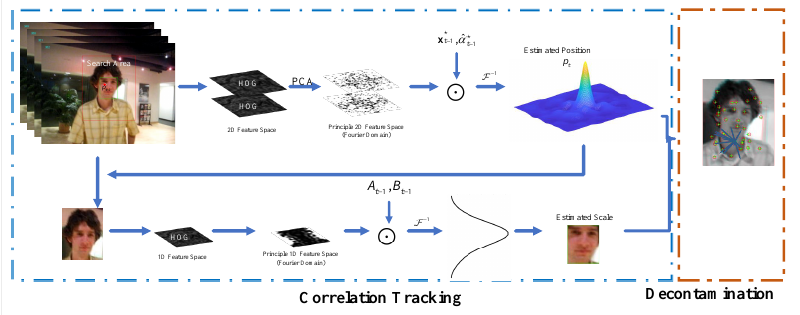
Figure 1. Overview of the proposed algorithm The tracking task is decomposed into three parts, namely translation, scale estimation, and decontamination. The position p t is infered from the correlation response map using translation model ˆ x (cid:63) scale model A t − 1 , B t − 1 . After both position and scale are estimated, the proposed keypoint-based decontamination approach is used to choose the reliable frame to update